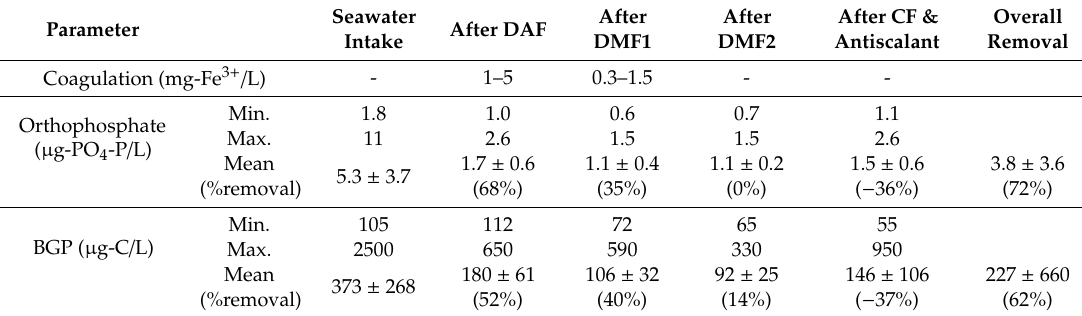
Table 5. Orthophosphate and bacterial growth potential (BGP) along the pre-treatment of the SWRO desalination plant over a 5 month period. Parameter